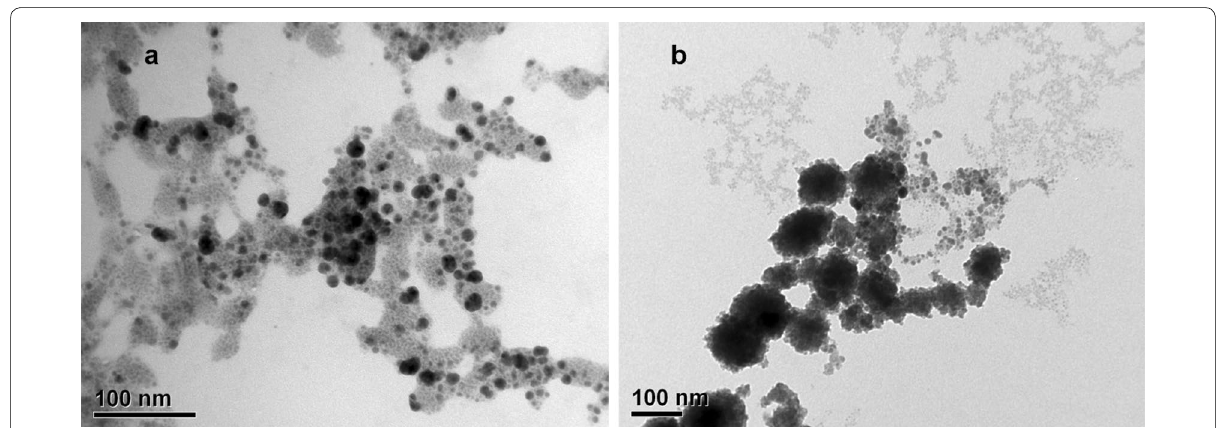
Fig. 3 Transmission electron microscope (TEM) image of Ag10‑COOH ( a ) and Ag10‑NH 2 ( b ) in